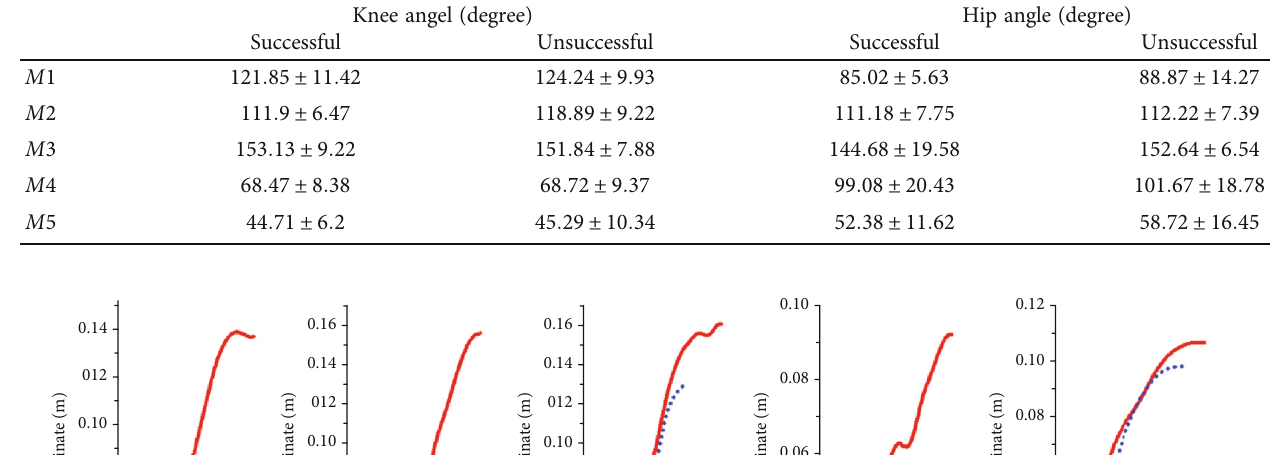
Table 4: Angles of hip and knee joints at the end of each phase of successful and unsuccessful snatch.